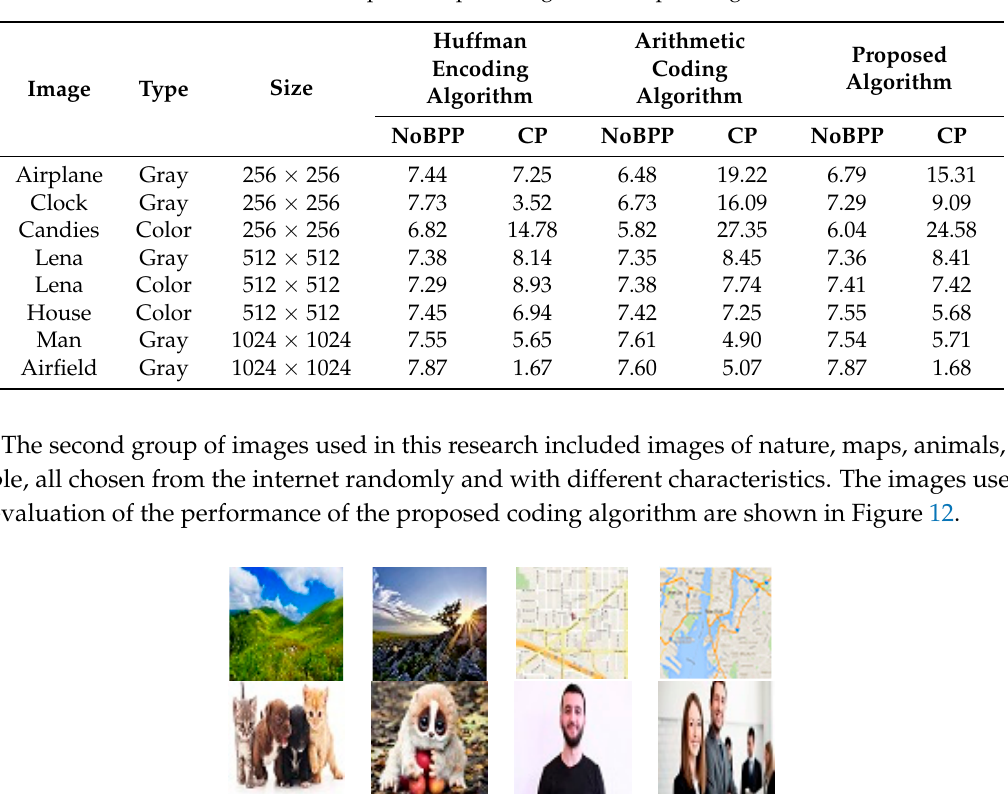
Table 7. Compression percentages of Group 1 images.